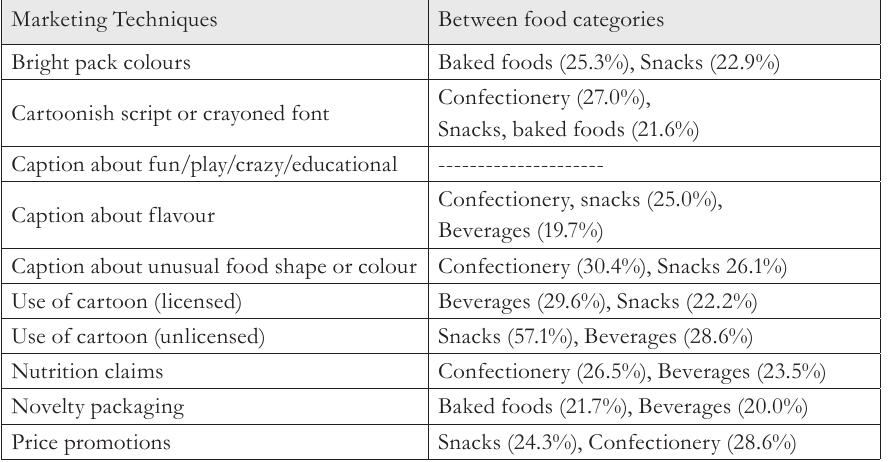
Tab. 4 - Use of Marketing Techniques across Food Categories. Source: author’s own